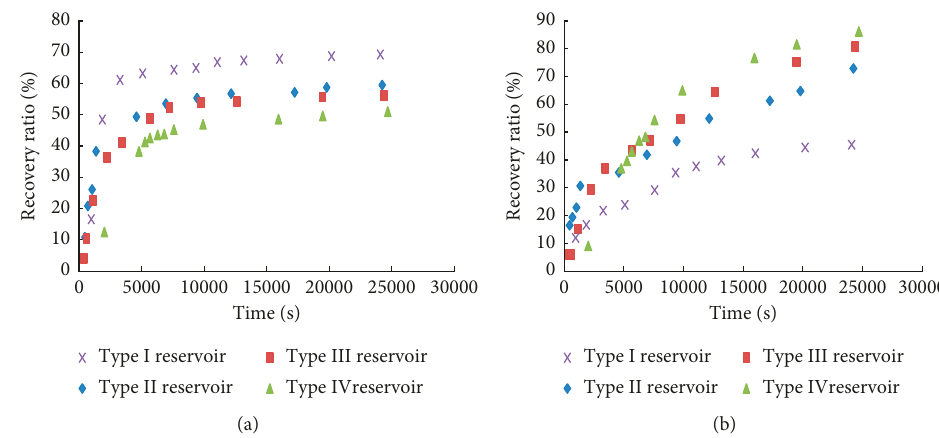
F IGURE 4: Recovery curve of tight reservoirs with water injection/gas injection. (a) Time-dependent recovery curve of tight reservoirs with water injection. (b) Time-dependent recovery curve of tight reservoirs with nitrogen Table 4: Recovery of different types of reservoirs. Development mode Water injection Gas injection Table 5: Recovery of reservoirs under different development modes. Different Water development mode